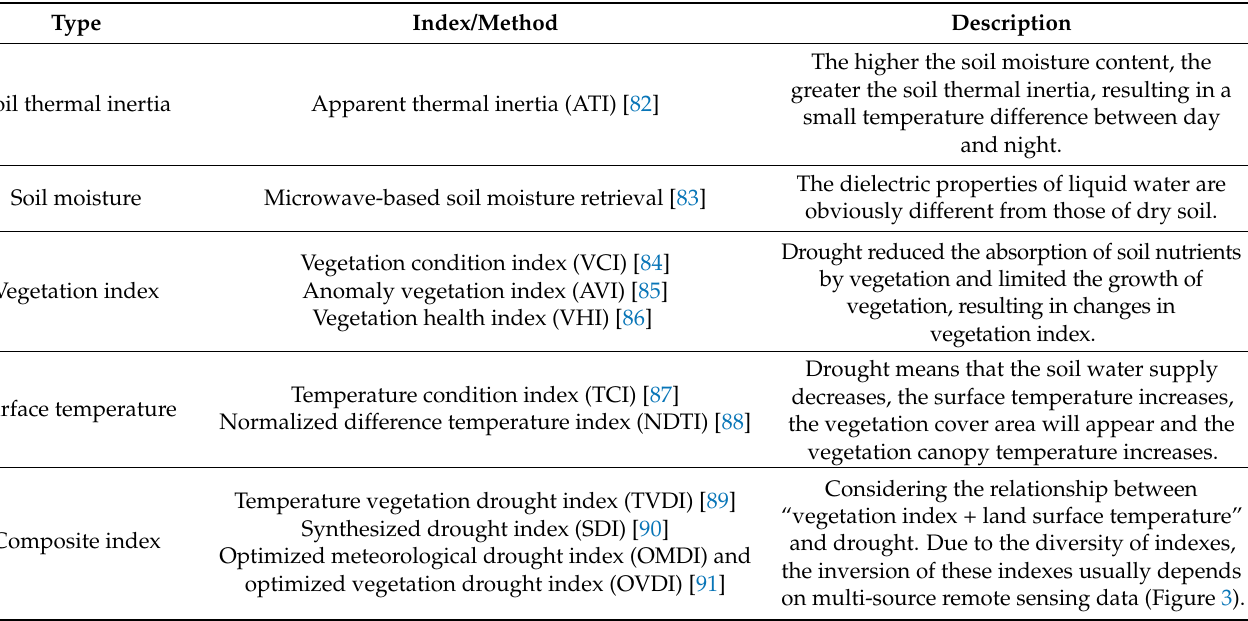
Table 3. Information extraction of drought.